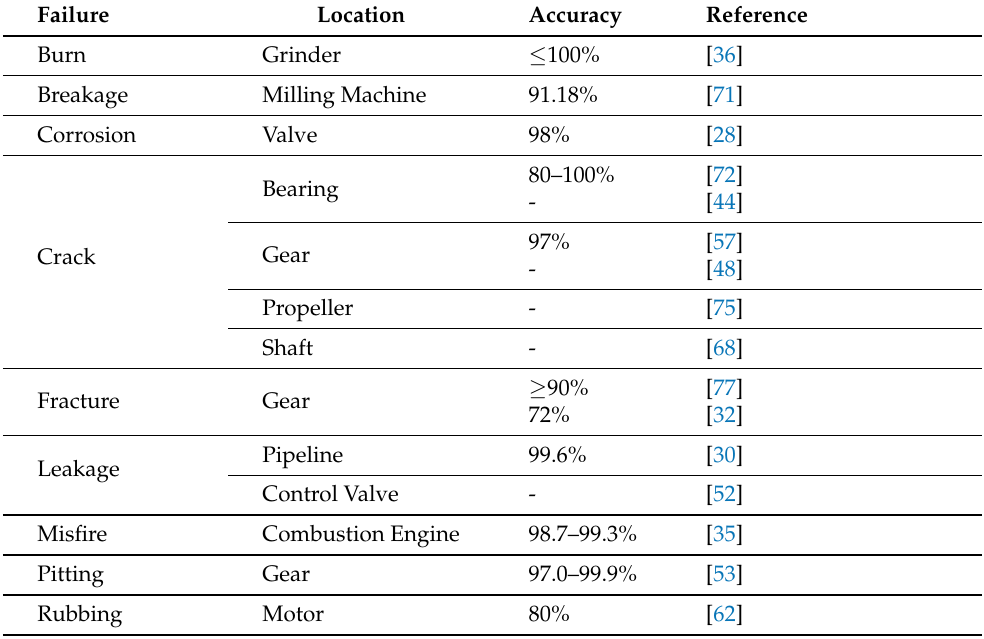
Table 7. Types of failure detected by acoustic